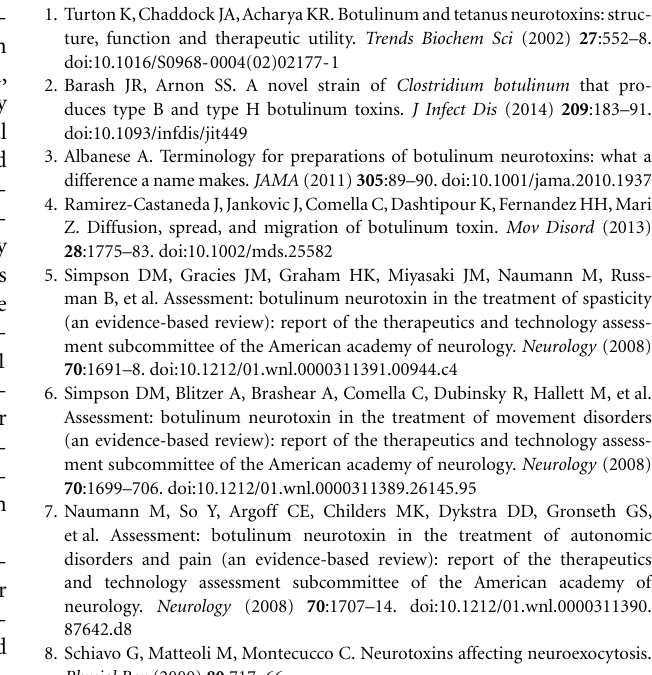
FIGURE 7 | Possible mechanisms for the central actions of intramuscularly injected BoNT/A in the spinal cord . Following unilateral intramuscular BoNT/A1 (A) or BoNT/A2 (B) injection, the catalytically active toxin can be axonally transported to the spinal cord through motor and sensory nerves. Subsequently, the toxin can spread throughout the gray matter of the spinal cord, including the bilateral ventral and dorsal horns, via a transcytosis (cell-to-cell trafficking) mechanism by which a ligand penetrates